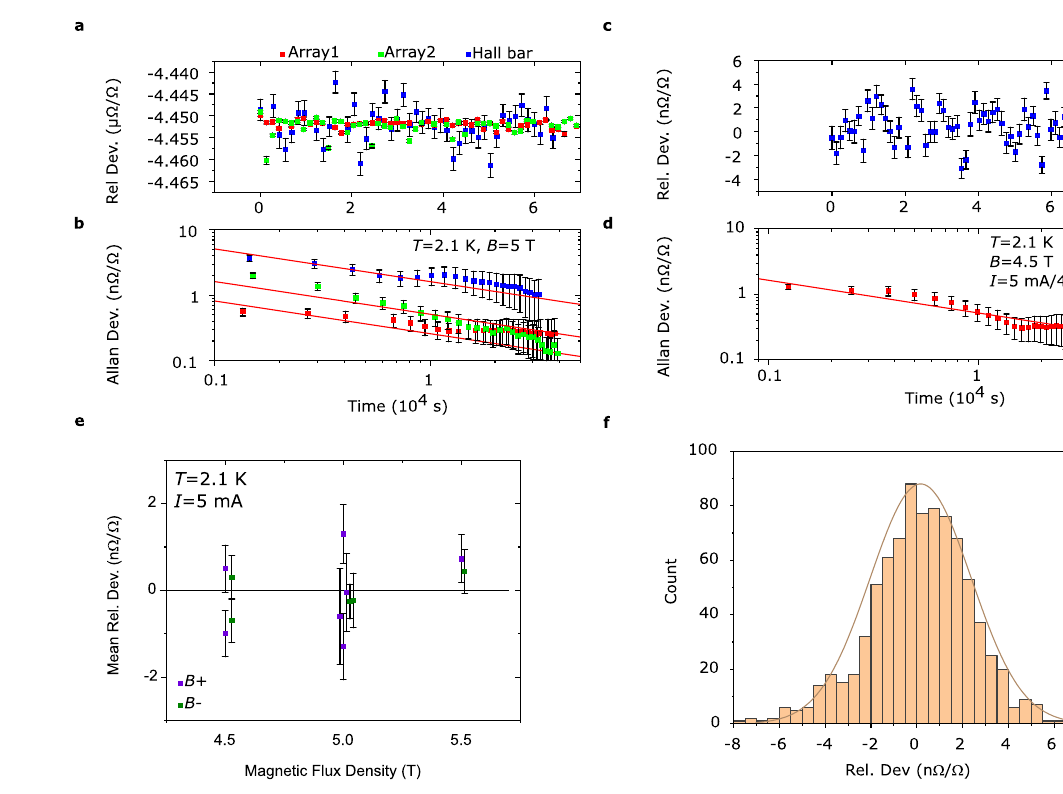
Figure 4eshowssimilarmeasurementstaken at different magnetic fl ux densities and the histograminFig. 4f showsthat the data is dominated